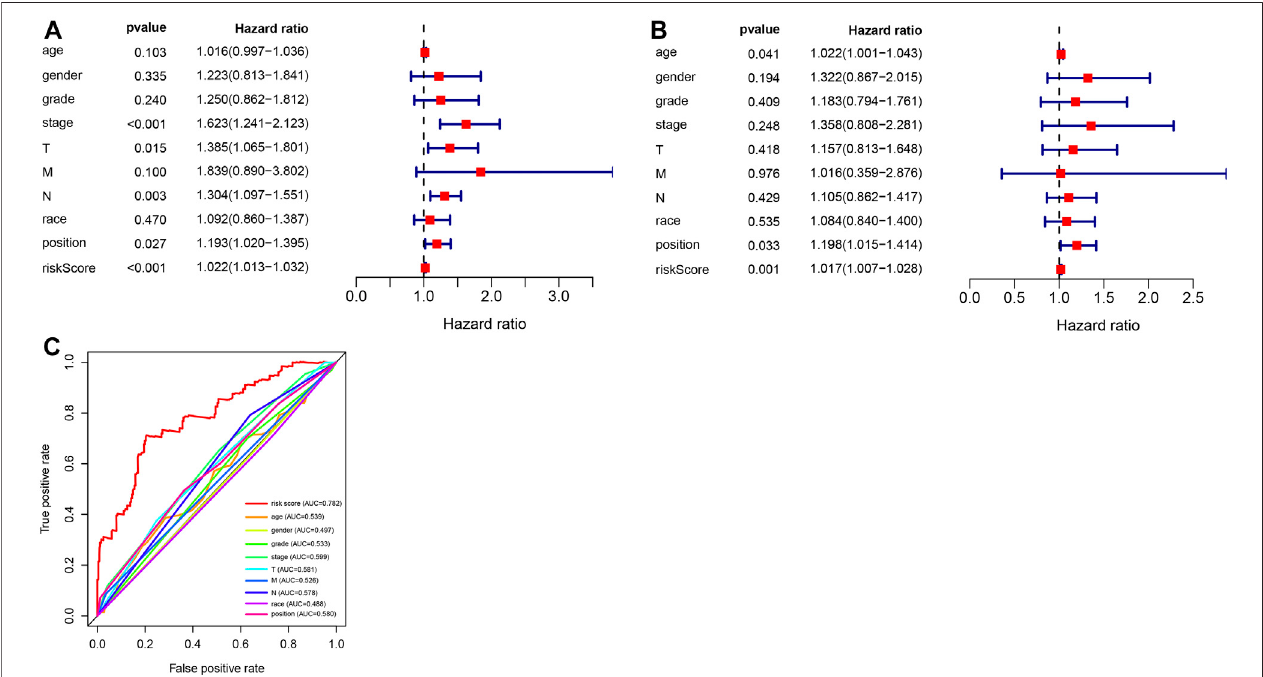
FIGURE 6 | Analysis of independent prognostic factors in the prognostic risk model. (A) Random forest plot of univariate independent prognostic analysis; the left side indicates clinical characteristics of gastric cancer (GC), the middle is the p -value. The hazard ratio indicates the risk rate with hazard ratio > 1 indicating high-risk clinical features, and hazard ratio < 1 indicating low-risk clinical features. (B) Random forest plot of multivariate independent prognostic analysis; the left side represents clinicalcharacteristicsofGC,themiddleisthe p -value.Thehazardratiorepresentstheriskratewithhazardratio > 1indicatinghigh-riskclinicalfeatures,andhazard ratio < 1indicatinglow-risk clinicalfeatures. (C) Receiver operating characteristicscurveanalysisoftheprognosticmodel constructed with elevendifferential methylation sites (DMSs) in GC.